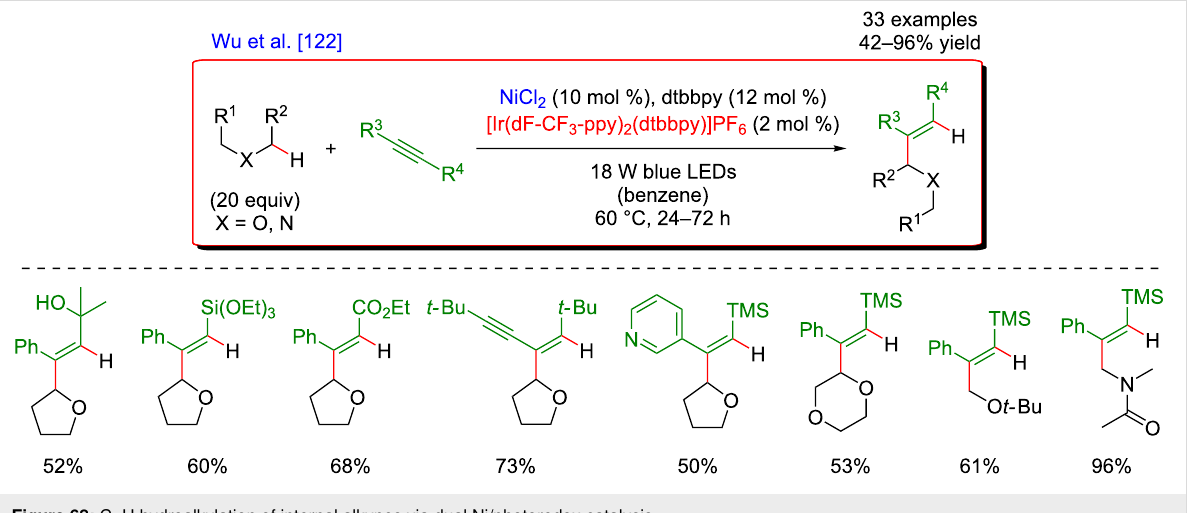
Figure 68: C–H hydroalkylation of internal alkynes via dual Ni/photoredox